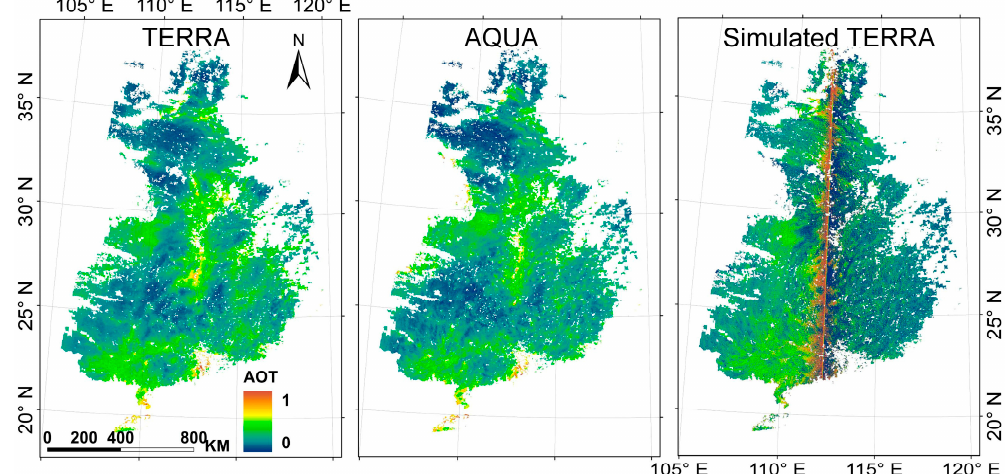
Figure 4. Comparison of AOT data at 550 nm. The left frame denotes TERRA MODIS aerosol retrieval, the middle frame denotes AQUA MODIS retrieval, and the right frame denotes the aerosol retrievals in this study.